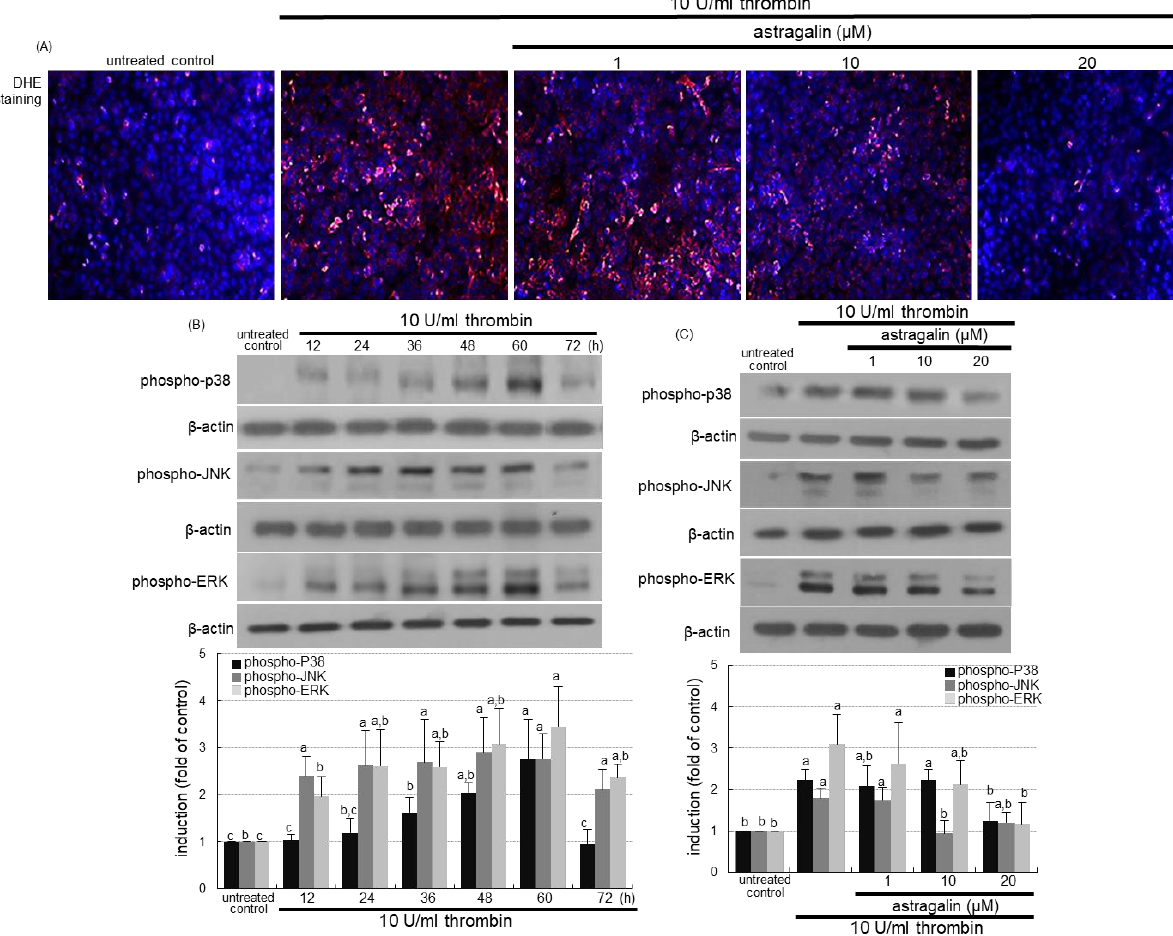
Figure 6. Inhibition of oxidant production ( A ), temporal activation of mitogen-activated protein kinase (MAPK) signaling ( B ) and their inhibition ( C ) by astragalin in thrombin-treated A549 cells. Alveolar epithelial cells were incubated in media containing 10 U/mL thrombin in the absence and presence of 1 –20 μM astragalin for up to 72 h. For the measurement of the reactive oxygen species production, dihydroethidium (DHE) staining was conducted in thrombin-treated A549 cells ( A ). Nuclear staining was done with 4′,6-diamidino-2-phenylindole (blue). Each photograph is representative of stained cells. Magnification: 200-fold. Cell lysates were subject to Western blot analysis with a primary antibody against phospho-p38, phospho-c-Jun N-terminal kinase (JNK) or phospho-extracellular signal-regulated kinases (ERK) ( B , C ). β -Actin protein was used as an internal control. The bar graphs (mean ± SEM, n = 3) represent quantitative results of the upper bands obtained from a densitometer. Values in bar graphs (same achromatic colored) not sharing the same lower case alphabet letter indicate a significant difference at p < 0.05.